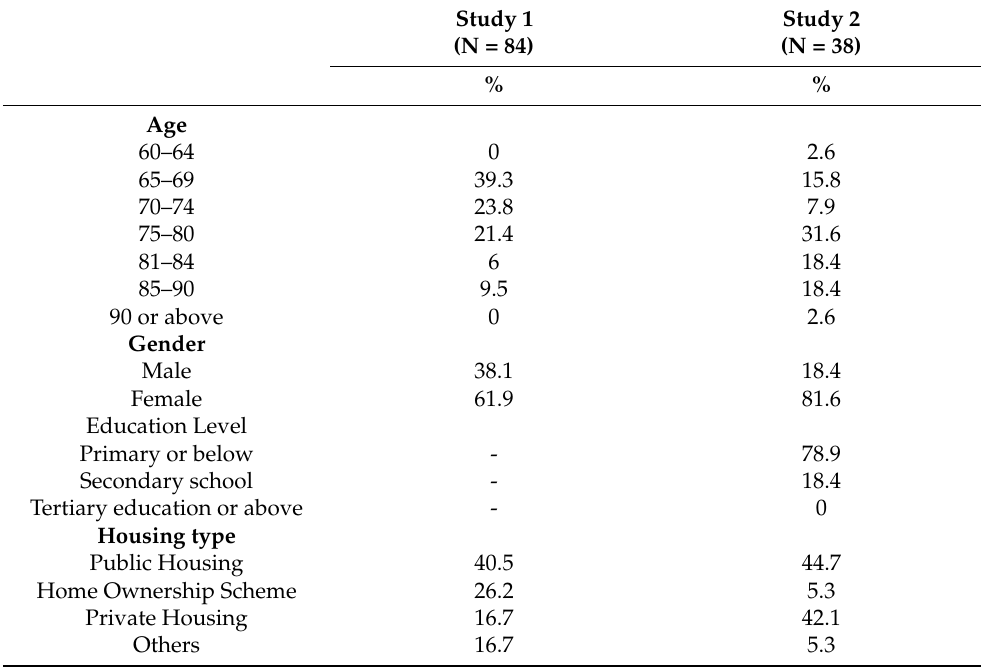
Table 1. The demographic characteristics of Study 1 and Study